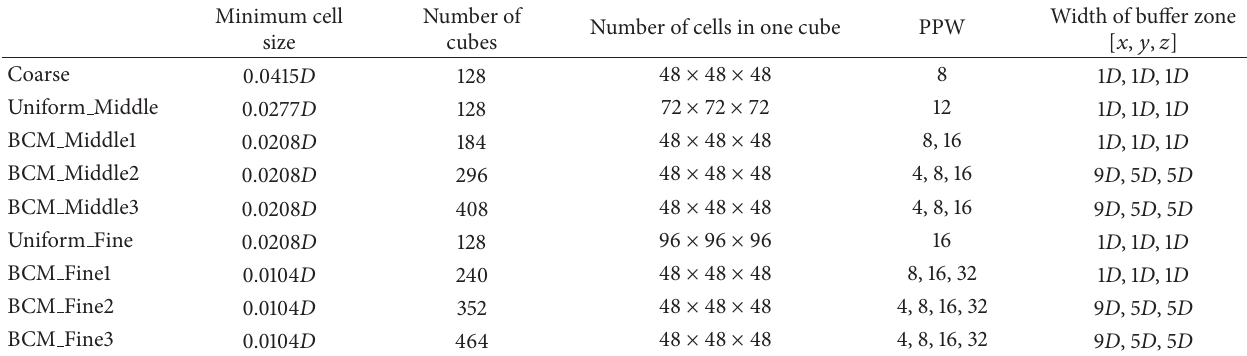
Table 2: Mesh information for acoustic scattering around a sphere of diameter 𝐷